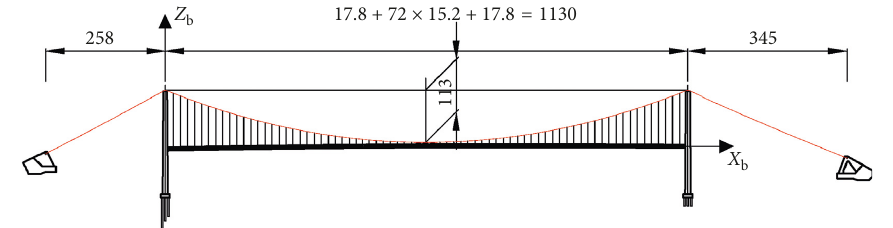
Figure 2: Configuration of the Qingshui River Bridge (unit: m).